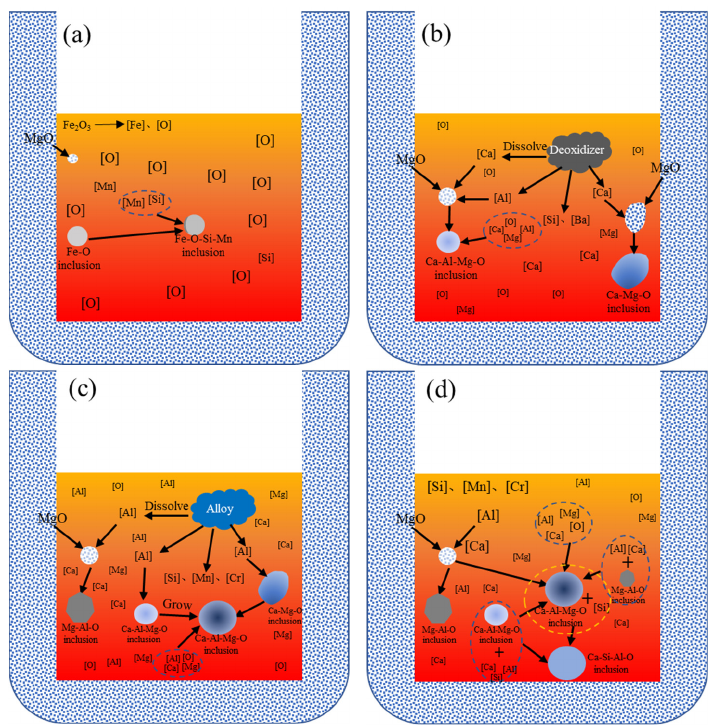
Figure 7. Schematic of inclusion evolution in liquid steel of scheme A. ( a ) steel melting; ( b ) deoxidizer addition; ( c ) alloy addition; ( d ) refining over